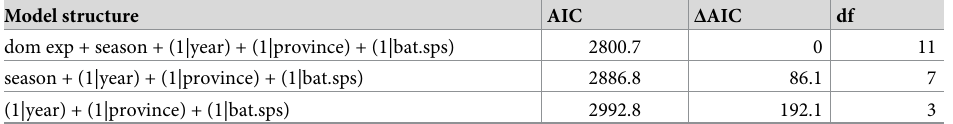
Δ AIC = change in AIC relative to the top model and df = the degrees of